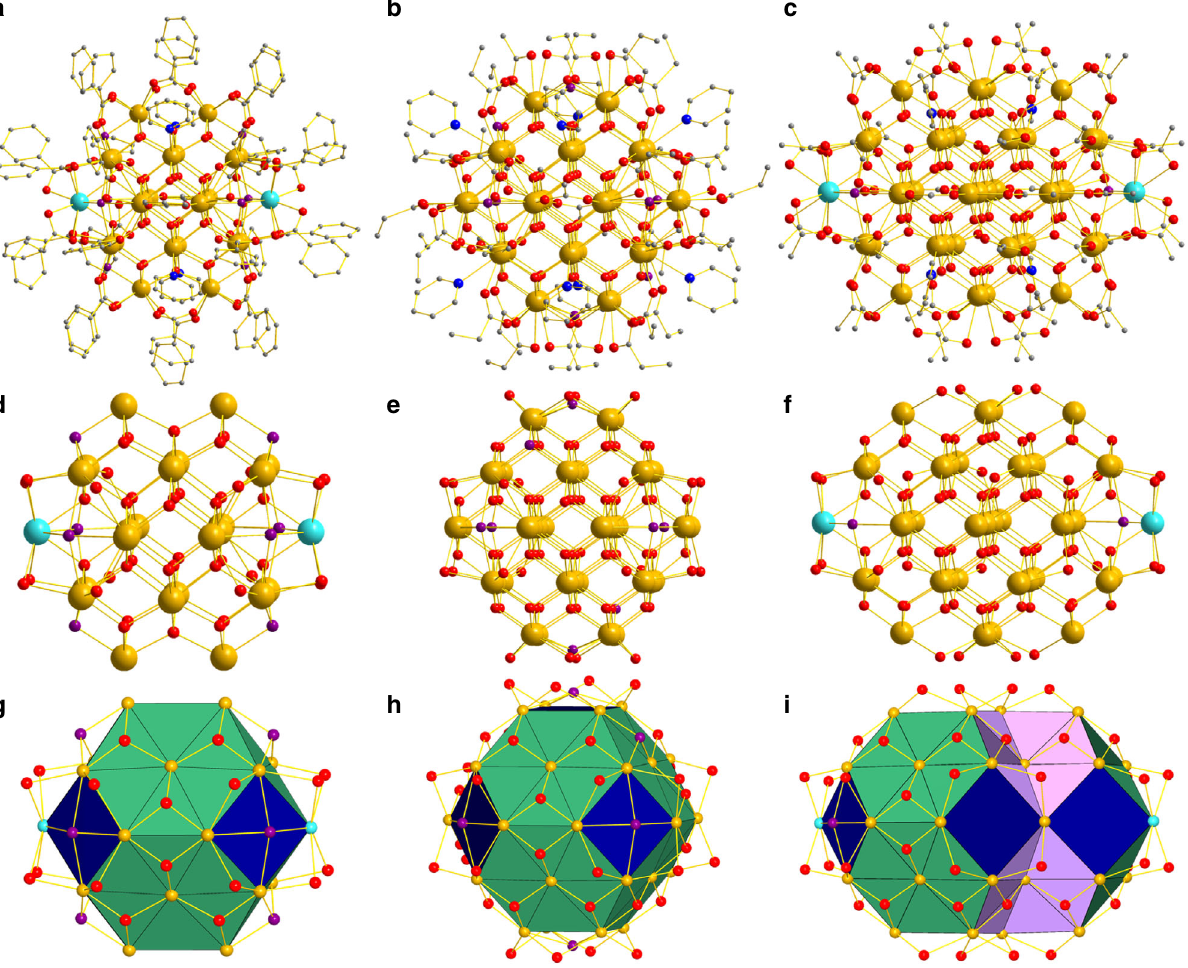
Fig. 1 Structures of ceria nanoclusters. a – c show the complete structures of 1 (Ce 24 ), 2 (Ce 38 ), and 3a (Ce 40 ), respectively. H atoms have been omitted for clarity. Atom sizes of C, N, and O are made small to emphasize Ce locations. Colour code: Ce IV gold, Ce III sky blue, O red, N blue, C grey. d – f show their Ce/O cores from the same viewpoint (including carboxylate O atoms that are bridging) using the same colour code except that protonated O atoms (i.e., OH − ions) are indicated in purple. g – i show the cores again, from approximately the same viewpoint but with surface facets colour-coded: (100) facets are blue; (110) facets are violet; (111) facets are green. Only carboxylate O atoms that are bridging are